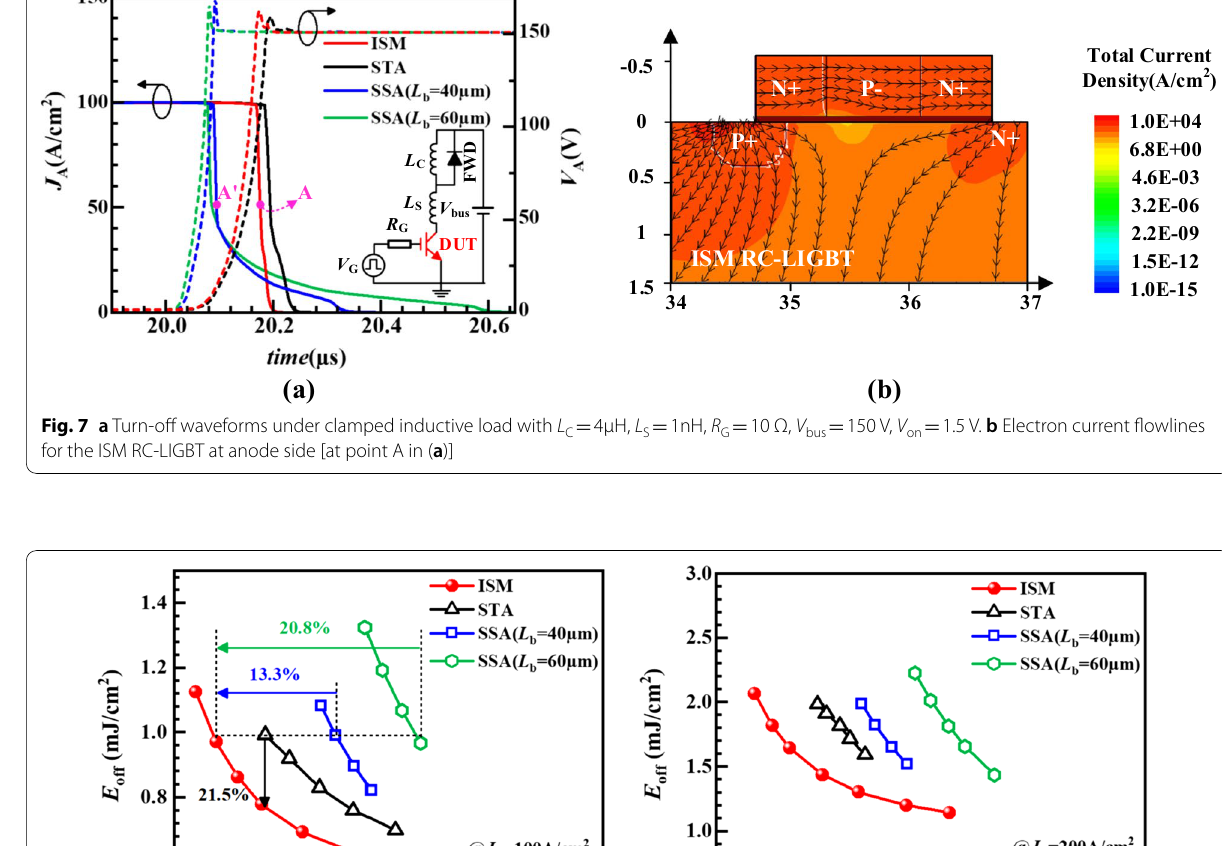
100A/cm 2 and b J A =